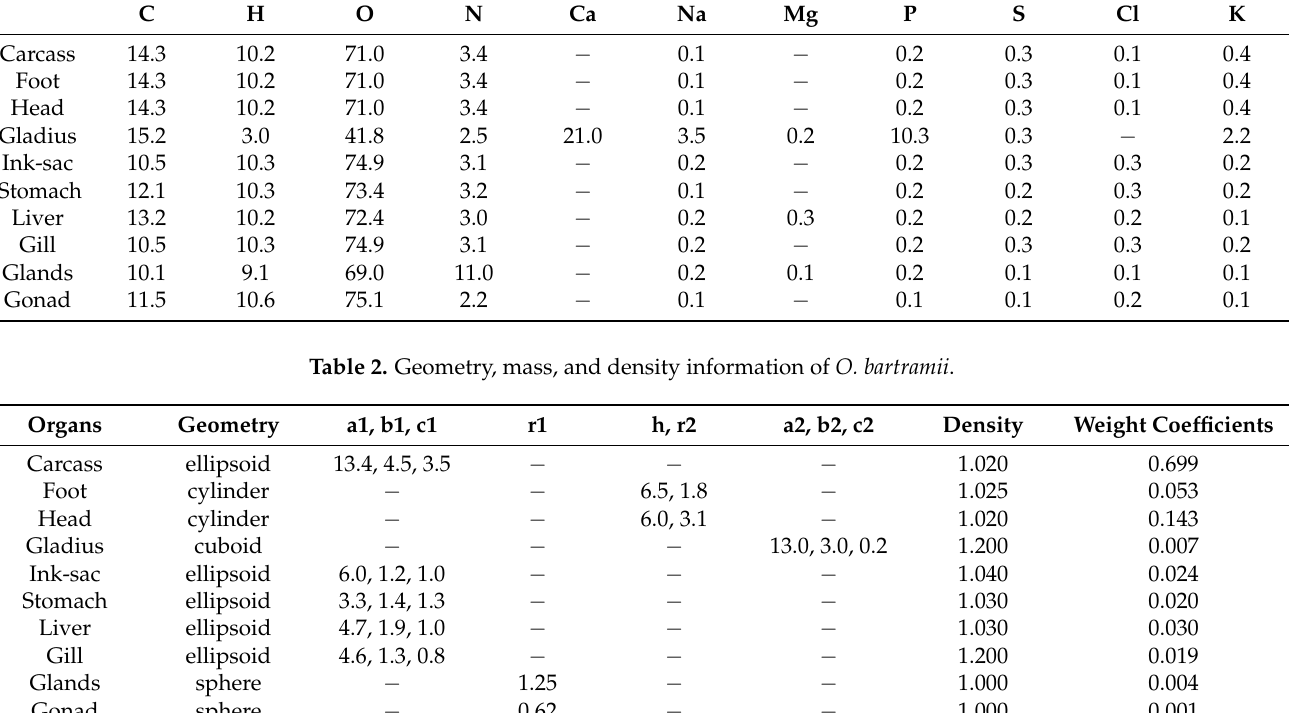
The parameters a1, b1, and c1 represented semi-axis lengths of ellipsoid; for sphere geometry, the parameter r1 represent the radius; for cylinder geometry, the parameters h and r2 represent the height and base-radius; for cuboid geometry, the parameters a2, b2, and c2 represent lengths, height, and width. The unit of lengths, heights, and width is ‘cm’ and the unit of density is ‘g cm − 3 ’.